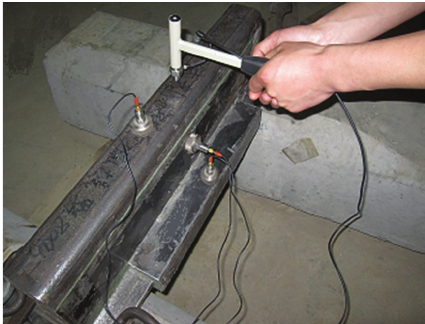
Figure 11: Treatment configurations